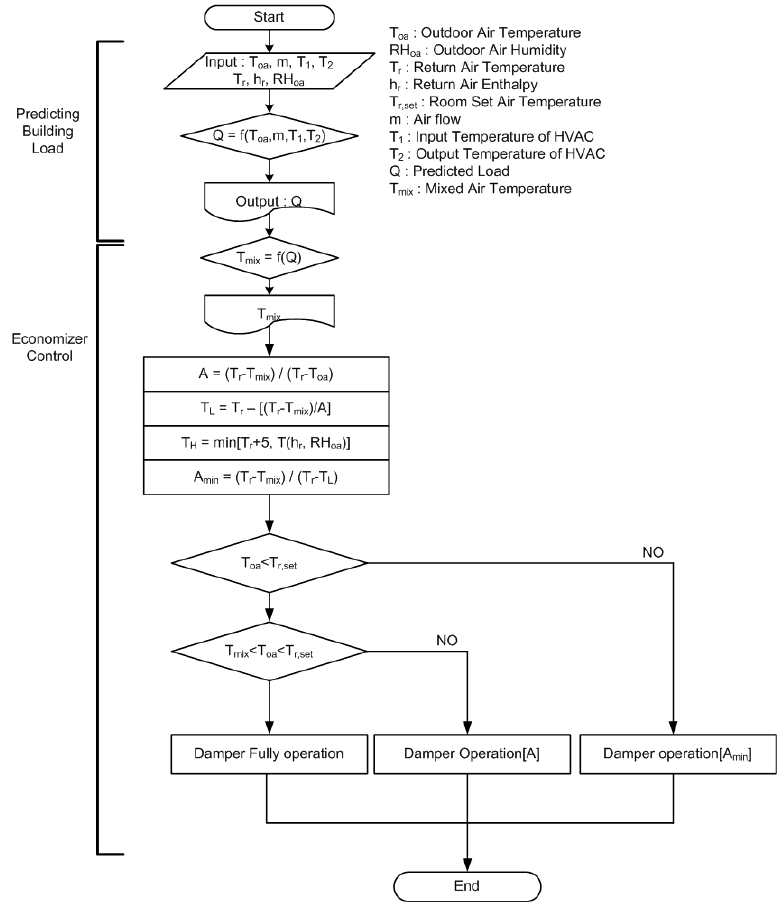
Figure 11. Proposed economizer algorithm.